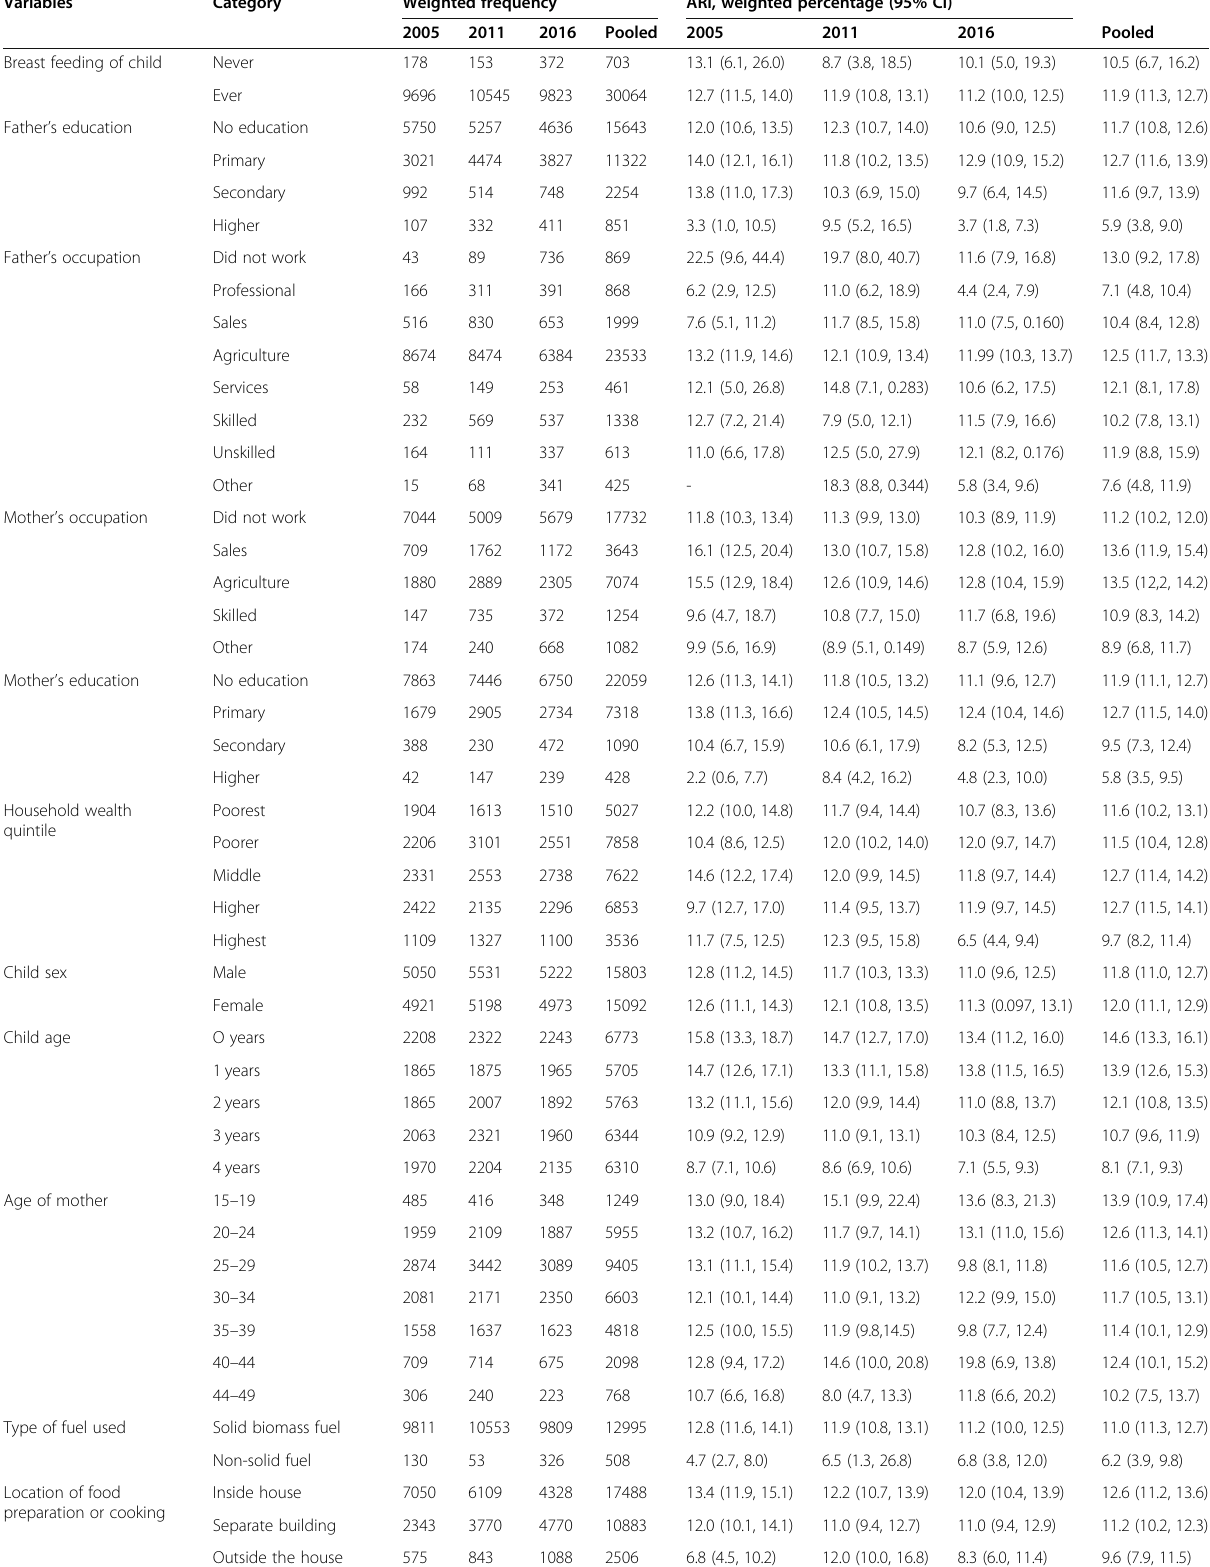
Table 2 Acute respiratory infection on under-five children across different variable selected, EDHS 2005 – 2016 Variables Breast feeding of